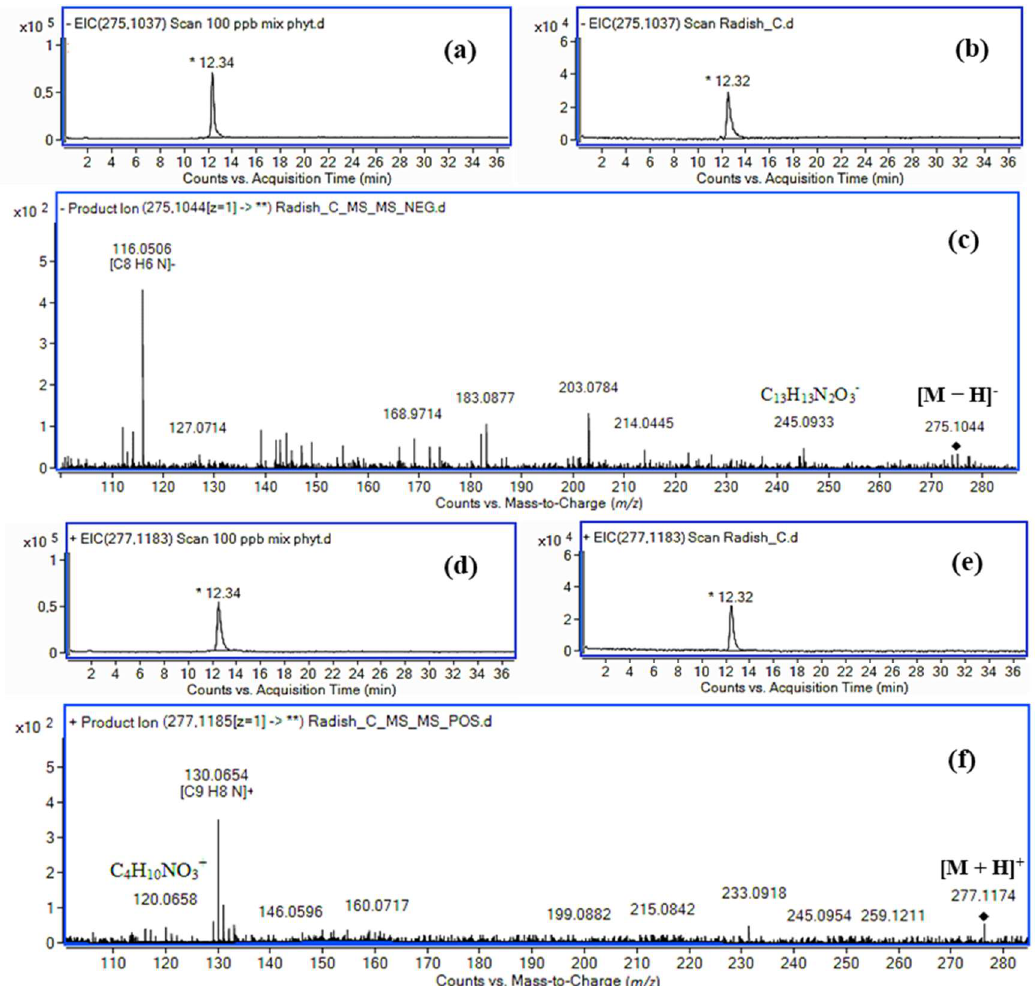
Figure 7. Extracted ion chromatograms for ( a ) a standard solution of IASer-Me, ( b ) a radish extract, and ( c ) an MS / MS spectrum of the extract in negative ionization mode. Extracted ion chromatograms for ( d ) a standard solution of IASer-Me, ( e ) a radish extract, and ( f ) an MS / MS spectrum of the extract in positive ionization mode.